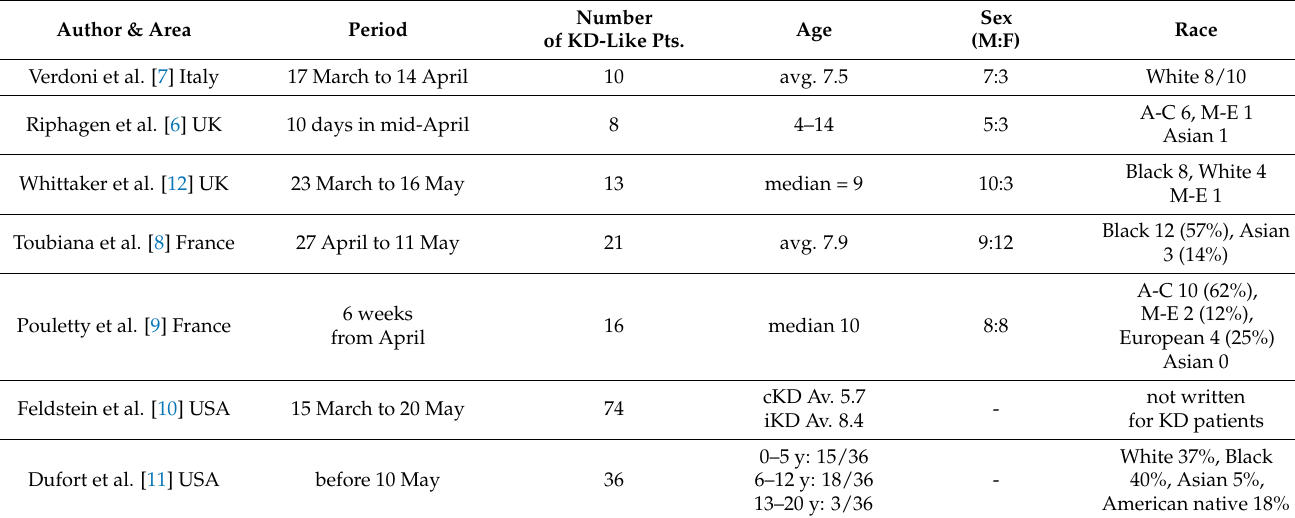
Table 3. The onset age and race of Kawasaki disease induced by severe acute respiratory syndrome coronavirus type 2 infections in Western